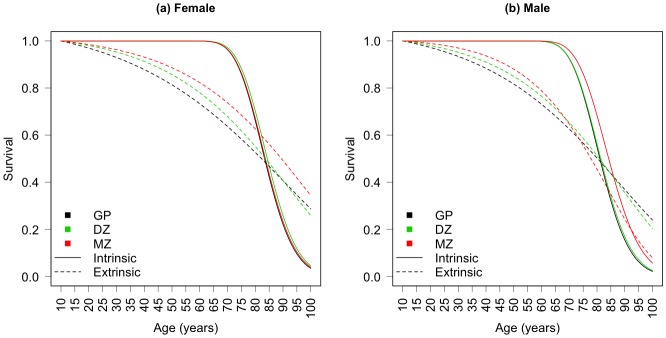
Fitted intrinsic and extrinsic age-specific survival functions.Fitted intrinsic (solid lines) and extrinsic (dashed lines) age-specific survival by sex and zygosity for the 1870–1900 Danish twin cohorts and the 1870–1900 Danish general population cohort. GP: general population, DZ: dizygotic, MZ: monozygotic.